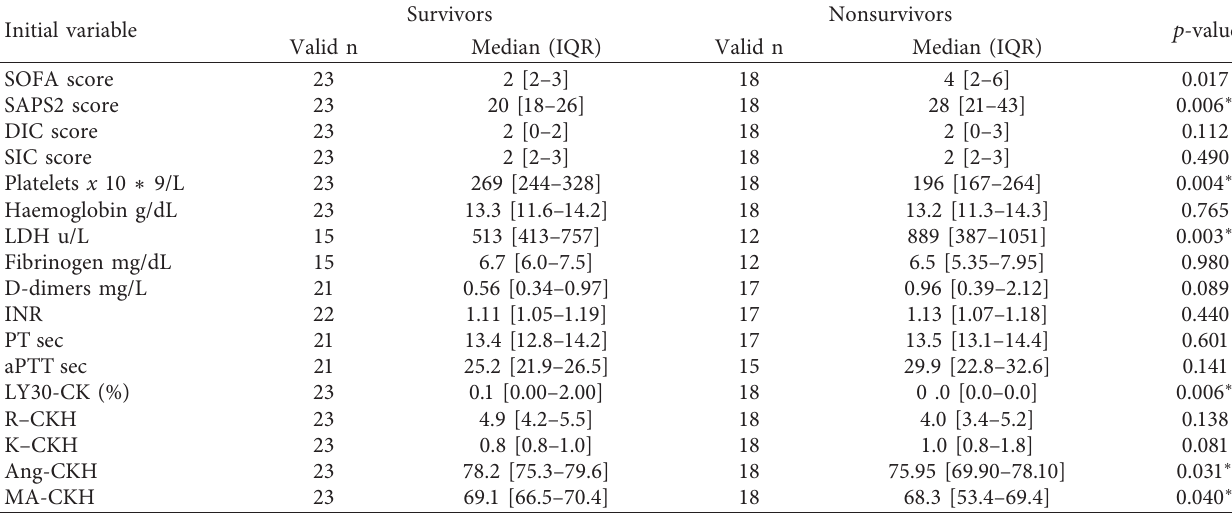
Table 3: Factors associated with